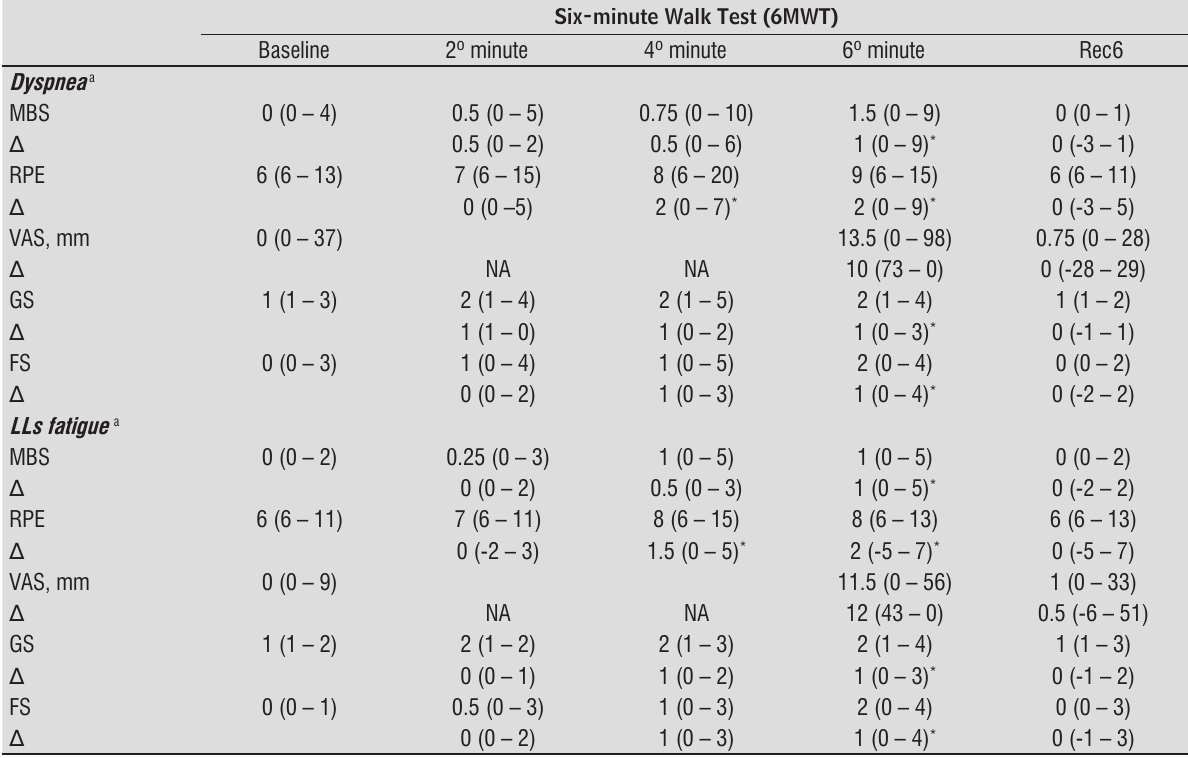
Table 3 - Dyspnea and lower limbs fatigue measured by the studied scales during the 6MWT